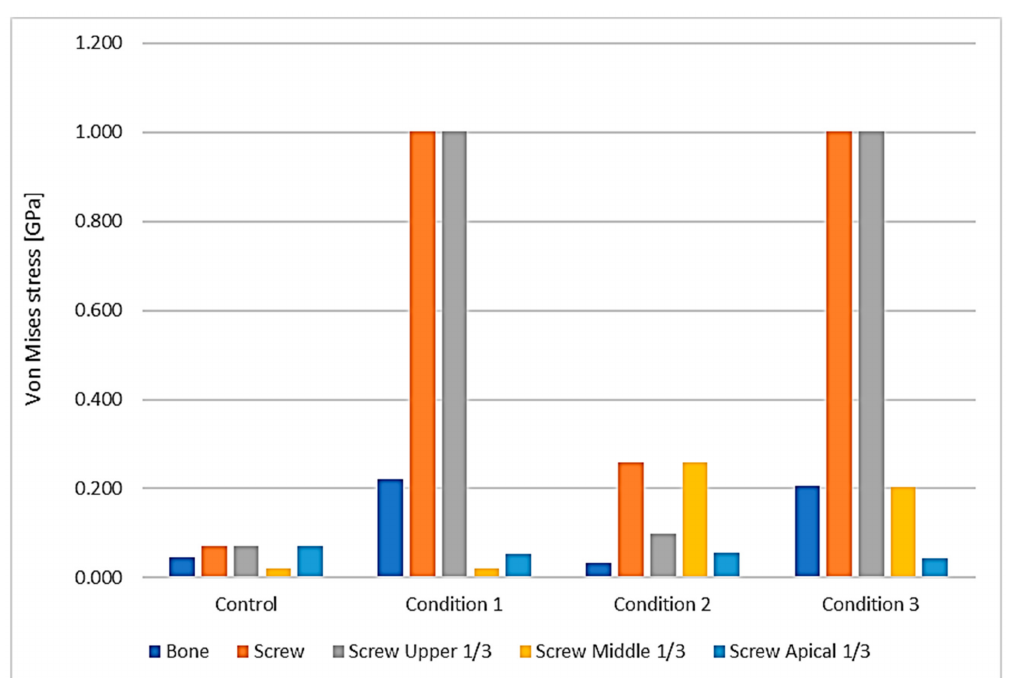
Figure 4. Distribution of the maximum Von-Mises stress at the bone and at the orthodontic miniscrew. The area of the miniscrew was divided into three parts according to their vertical positions: the upper third (gray), the middle third (yellow), and the apical third (sky blue). Maximum Von-Mises stress of each part is visualized in the graph. The orange one is the maximum Von-Mises stress of all screw parts. Upper third of the screw part showed the maximum Von-Mises stress in condition 1 and 3, while the middle third of the screw part showed the maximum Von-Mises stress in condition 2. In all the conditions, the maximum Von-Mises stresses of bone and entire screw were much higher than the control, especially in conditions 1 and 3.